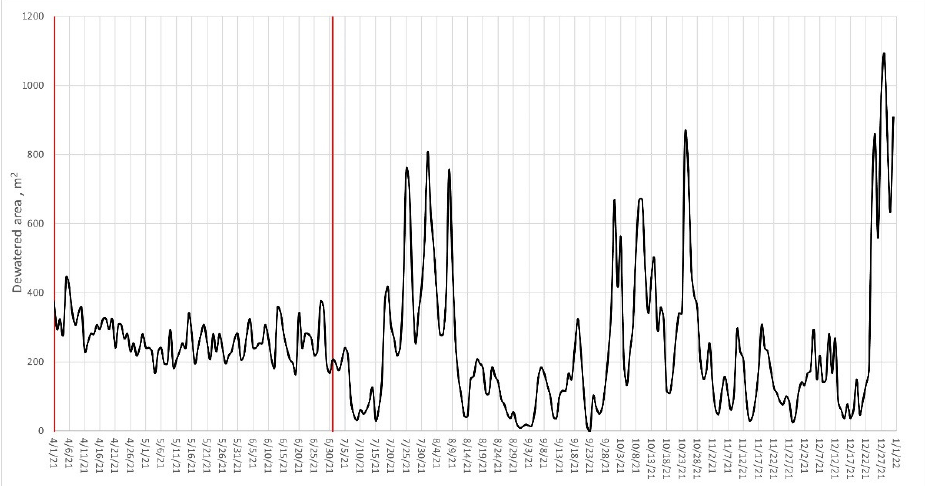
Figure 8. Dewatered area changes in the selected potential fish spawning site (black line). The fish spawning period is marked between two vertical red lines.